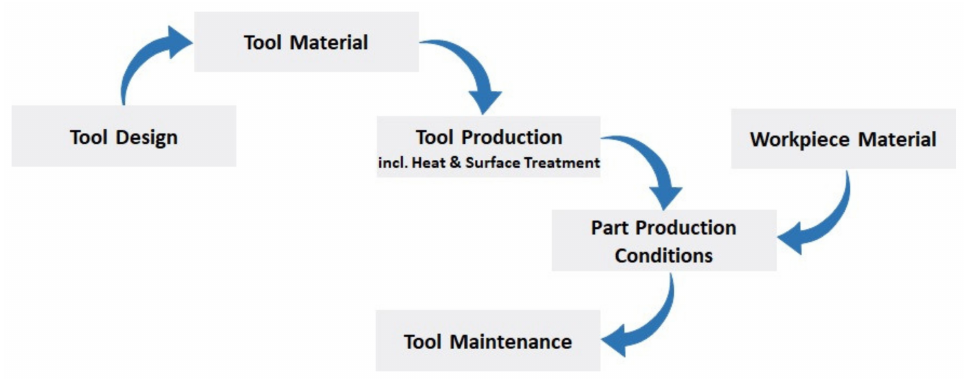
Figure 3. Factors that influence the tool life.